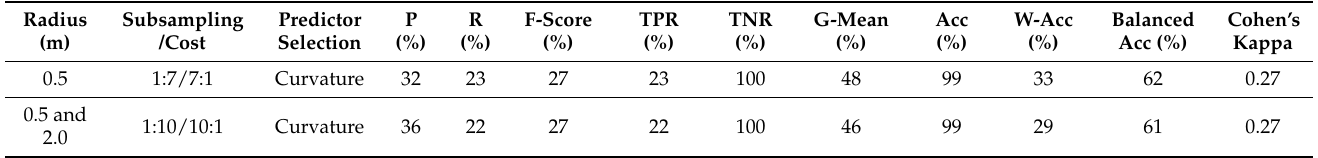
Table 4. Accuracy assessment with different performance scores for point-based analysis.